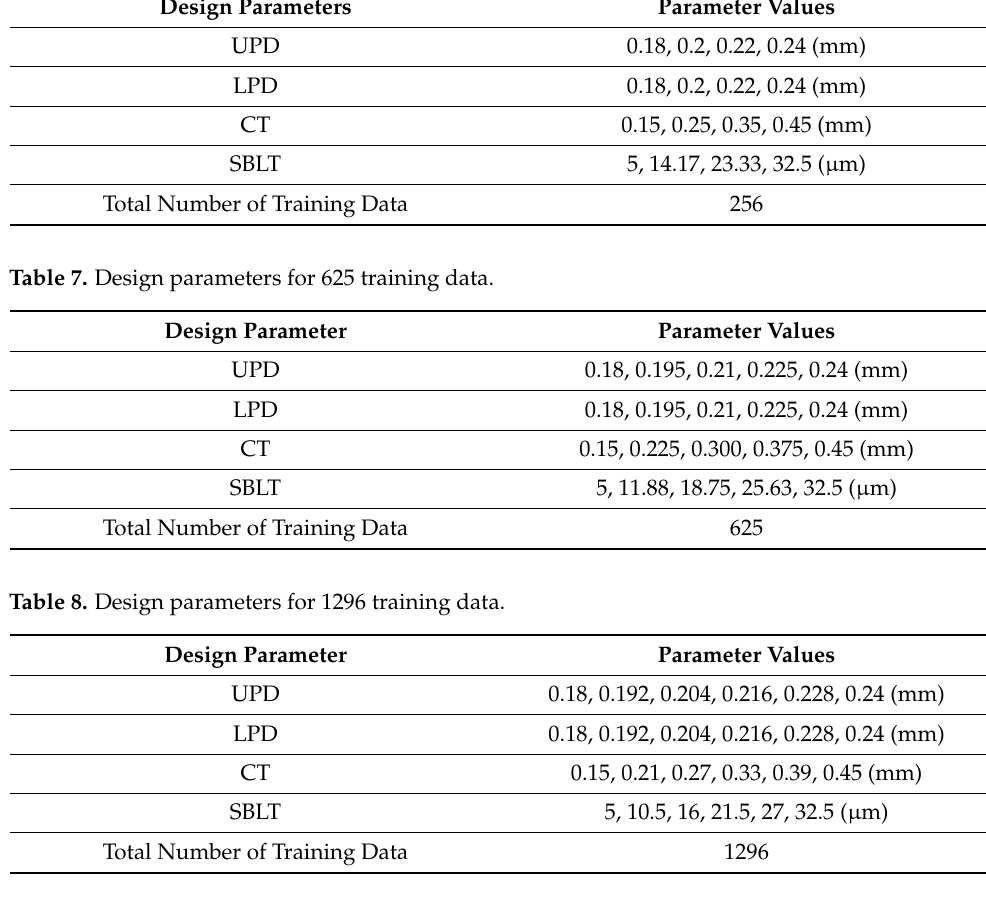
The design parameters for different training sets are shown in Tables 6–11.